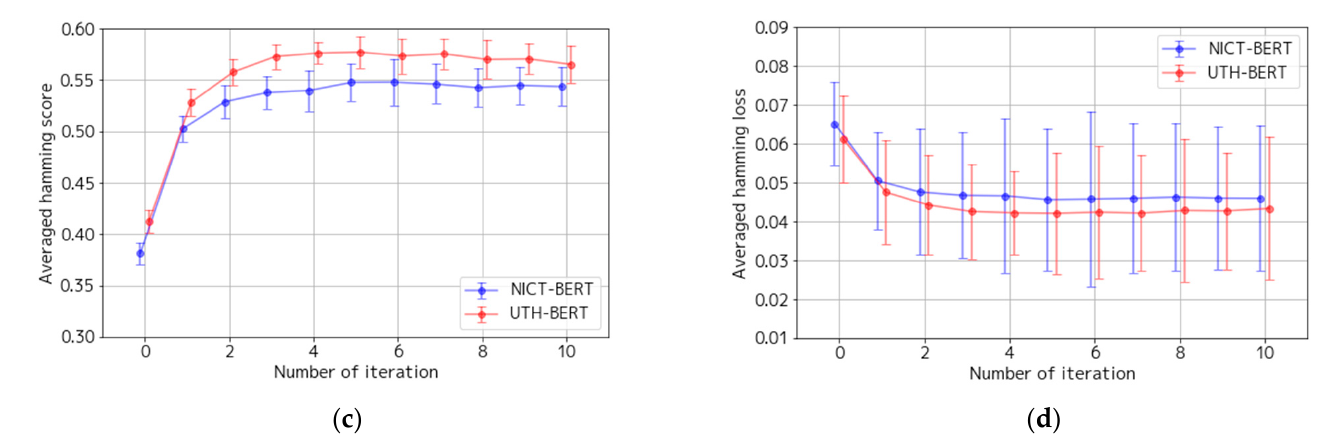
Figure 5. Changes in the numbers of label-matched pairs and evaluation metrics with the optimization iterations: ( a ) number of label-matched pairs, ( b ) averaged exact match ratio, ( c ) averaged Hamming score, and ( d ) averaged Hamming loss. The dots and the error bars indicate the mean and the standard deviation of the results from 10 different random seeds, respectively. To distinguish between UTH-BERT and NICT-BERT symbols, the UTH-BERT iteration number is offset by +0.1, and the NICT-BERT iteration number is offset by − 0.1. The zeroth iteration shows the results from the pretrained SBERT systems.